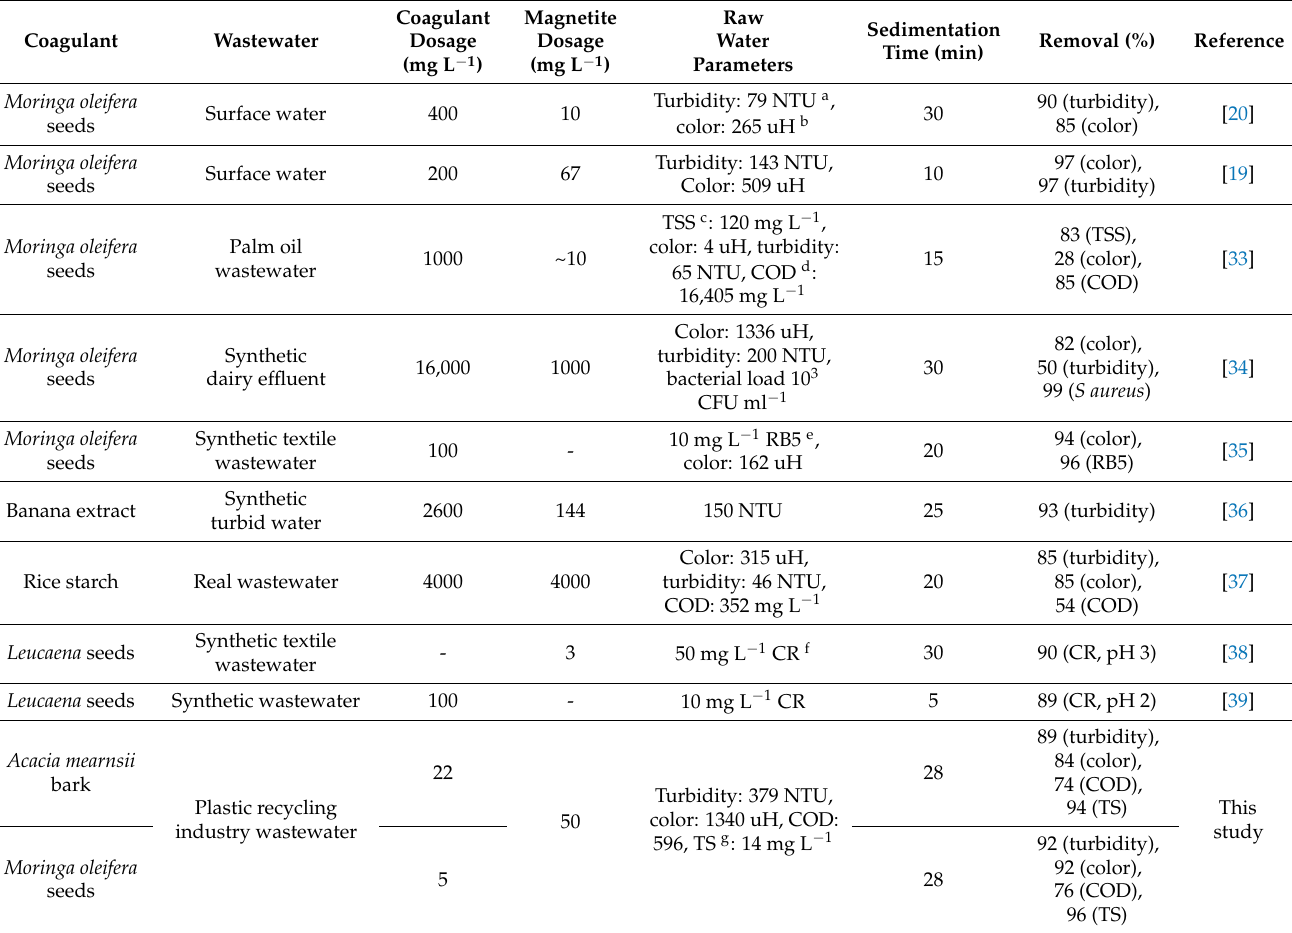
Table 8. Natural coagulants associated with magnetite